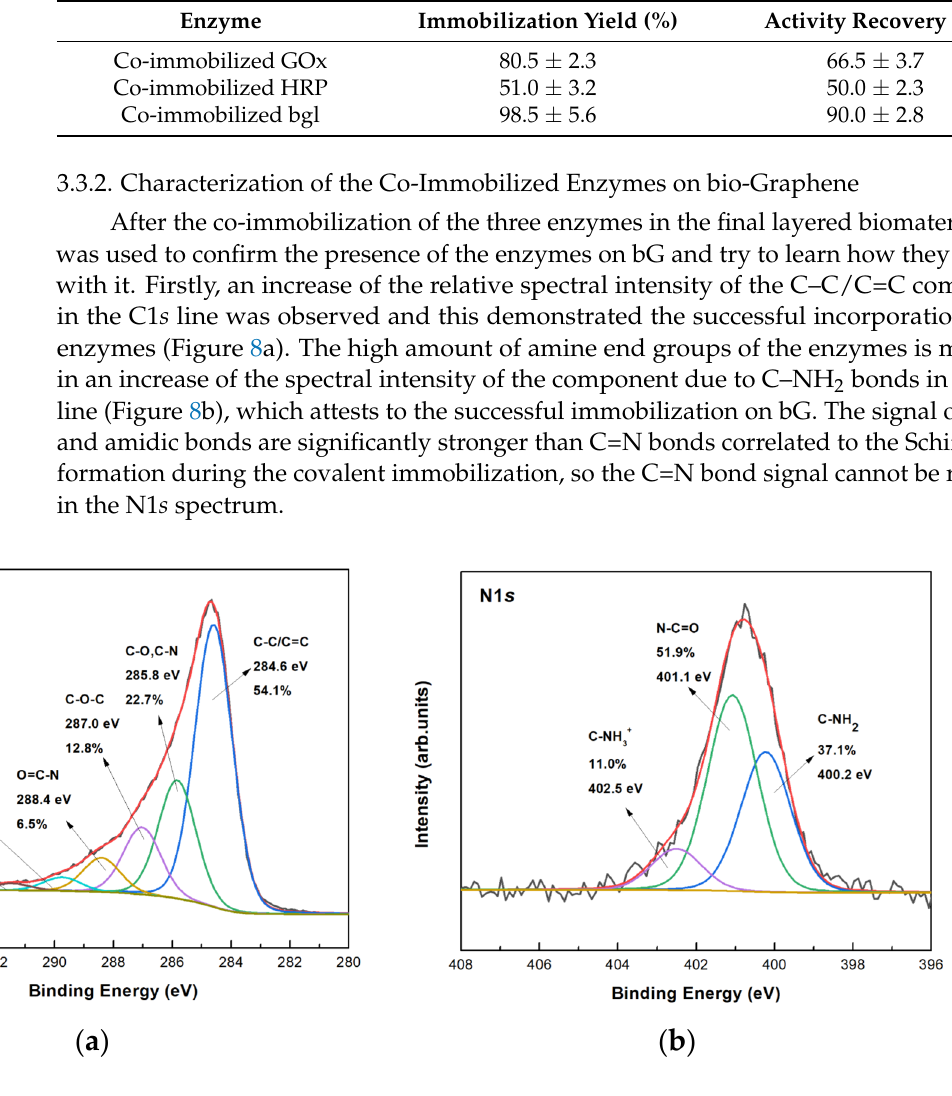
Figure 8. XPS spectra of the ( a ) C1 s and ( b ) N1 s core level regions of the tri-enzymatic system immobilized on bio-Graphene.